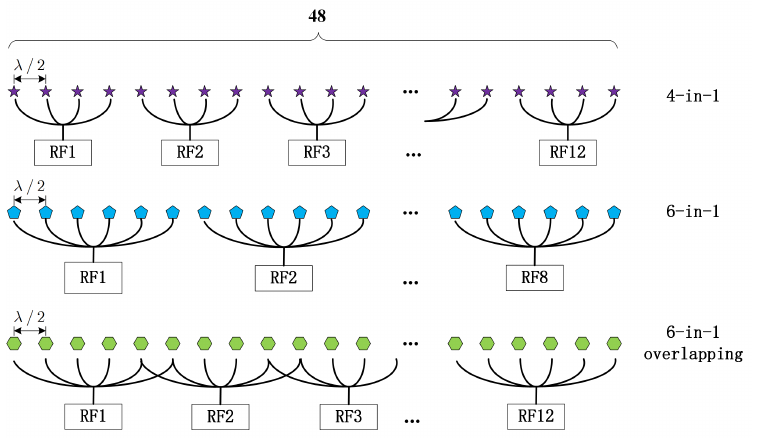
Figure 9. Different subarray structure studied for spatial sensitivity.